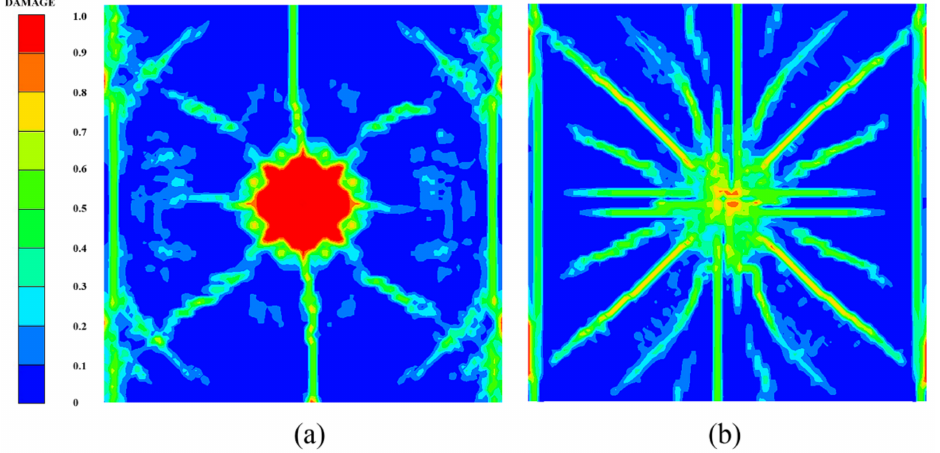
Figure 16. Numerical results of the SPH–FEM coupling model: ( a ) top surface; ( b ) bottom